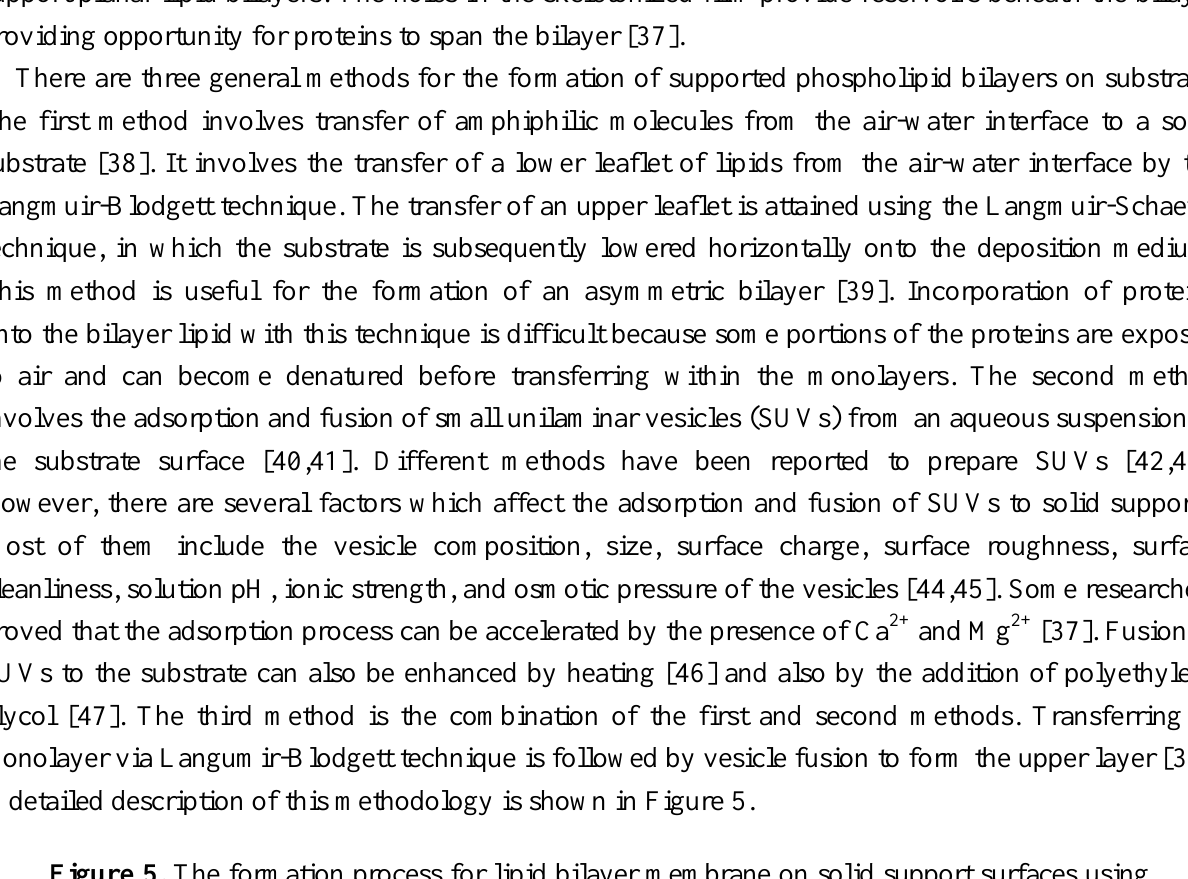
Figure 5. The formation process for lipid bilayer membrane on solid support surfaces using a combination of the Langmuir-Blodgett technique and vesicle fusion